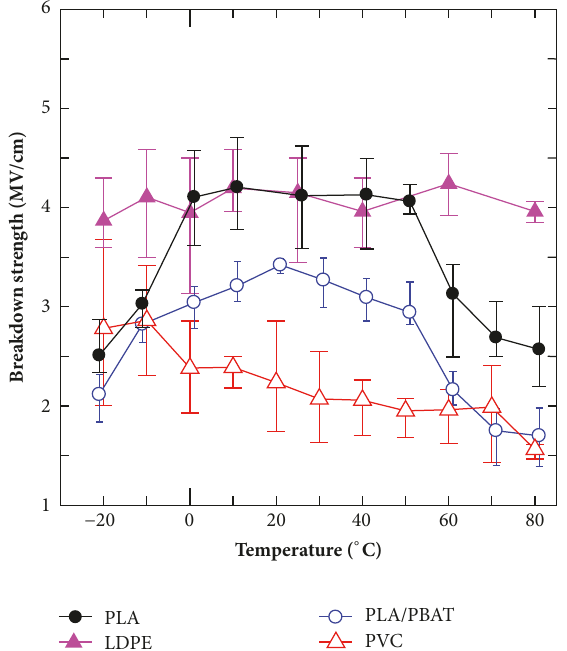
Figure 10: Dielectric breakdown strength of PLA and PLA/PBAT.